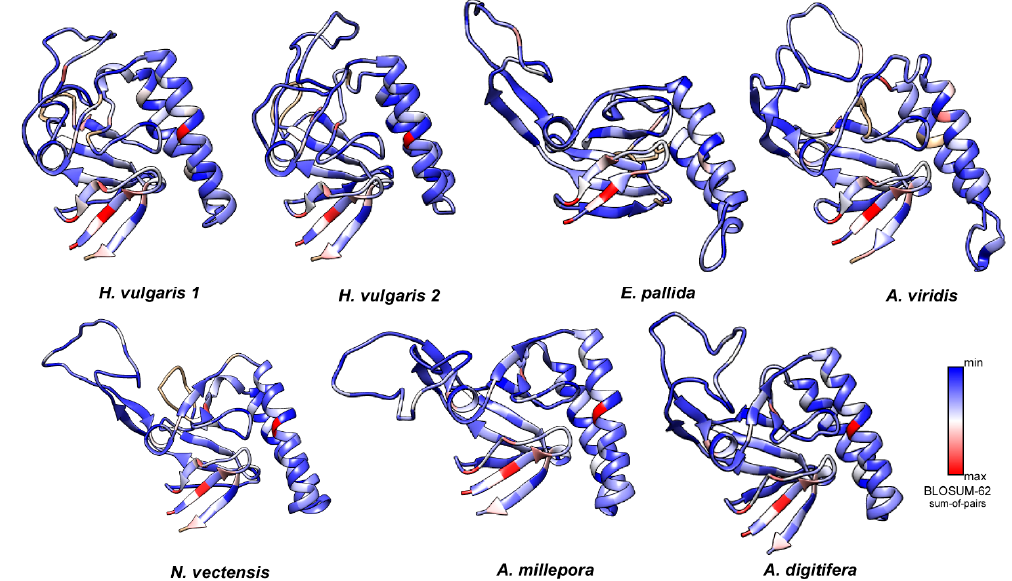
Figure 5. Molecular evolution of cnidarian TCTPs. Three-dimensional models in ribbon representation of various cnidarian homologues with their structure coloured according to the evolutionary conservation of amino acids. The 3D structures were created via the Phyre 2 software and rendered by using Chimera package. Variable positions are presented in blue; while conserved amino acids are showed in red as defined in the color-coding